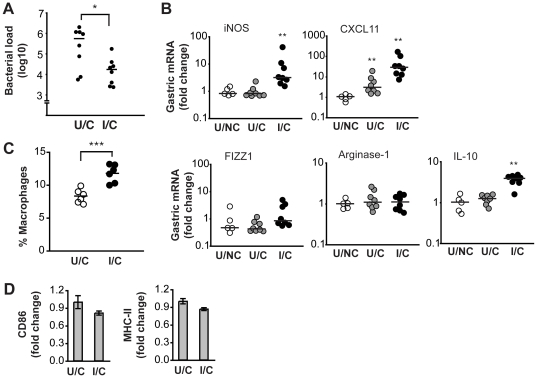
M1 polarization of gastric macrophages in immunized mice following challenge with H. pylori.Mice were immunized with H. pylori lysate and cholera toxin and challenged with H. pylori SS1 (I/C: immunized/challenged). A second group of mice was infected with SS1 without prior immunization (U/C: unimmunized/challenged) and a third group was left untreated (U/NC: unimmunized/non-challenged). (A) Number of bacteria cultured from the stomach of U/C and I/C mice four weeks after challenge. Horizontal bars indicate the median. *, P<0.05 via Mann-Whitney U test. (B) Four weeks after challenge the expression of genes associated with macrophage polarization was determined in the gastric mucosa of the mice shown in A by real-time PCR. Symbols represent individual mice, and horizontal bars indicate the medians. **, P<0.01 compared to the expression level in U/NC mice via Mann-Whitney U test. (C) In separate experiments, the frequency of gastric macrophages (Gr1−CD11b+CD103−Siglec-F−MHC-II+) in U/C and I/C mice was determined by flow cytometry three weeks after H. pylori infection. Each symbol represents individual mice, and horizontal bars indicate the mean. ***, P<0.001 via T test. (D) Flow cytometric analysis of CD86 and MHC-II expression by gastric macrophages (Gr1−CD11b+CD103−Siglec-F−MHC-II+) from the U/C and I/C mice shown in C. The geometric mean fluorescence intensity was normalized to the level in U/C mice. Data are presented as mean ± SEM.